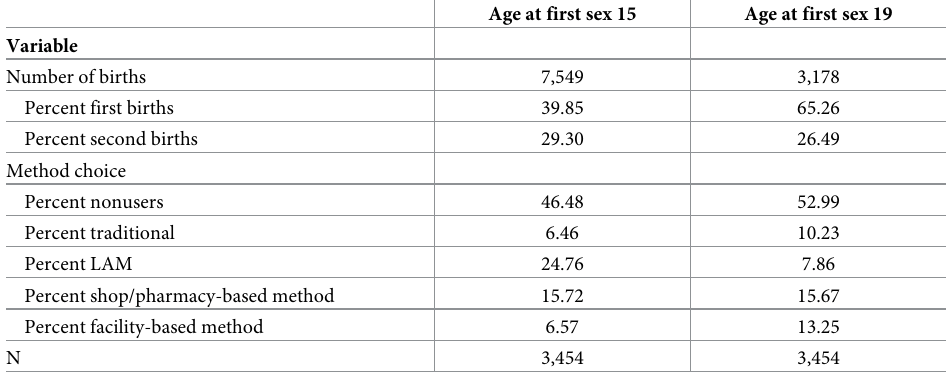
Table 5. The simulated effect of age at first sex on births and method choice by age 24 (corrected